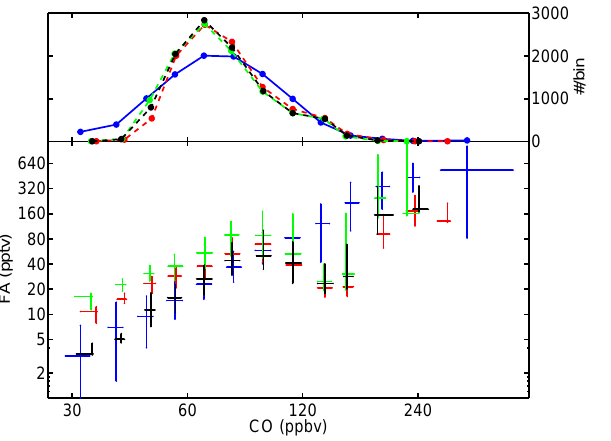
Fig. 8. The correlation between CO and FA observed by ACE- FTS (blue crosses) in the free troposphere is not well-captured by the model (green, red and blue crosses), suggesting a missing sec- ondary source. Lower panel: correlation plot between FA and CO (lower panel) for the measurements (blue) and the model: R1 (red), R2b (green), R4 (black). Upper panel: distribution of measured and modeled CO. The extent of the error bars indicate the 25 and 75 percentiles. The model is sampled at the location and time of the ACE-FTS measurement.